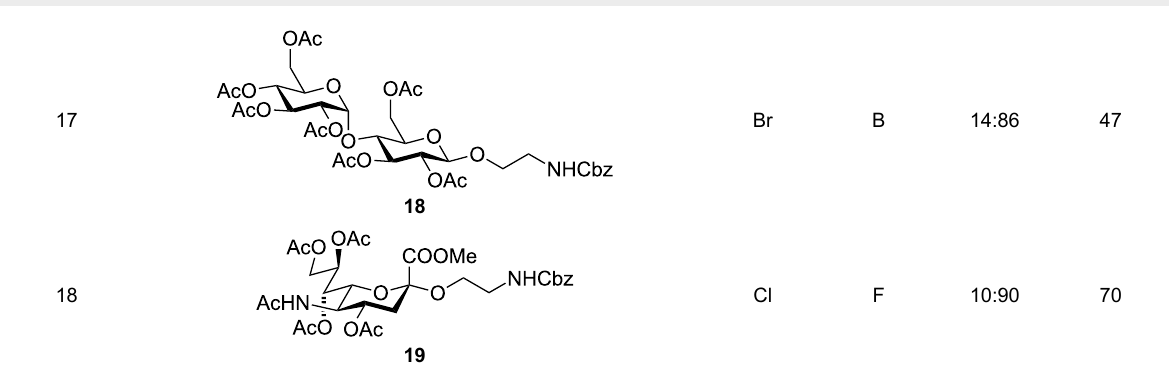
a The reaction was performed overnight at r.t. b The reaction was performed in CH 2 Cl 2 . c determined by 13 C NMR from crude reaction mixture. d Yield of pure major anomer (>95:5) after column chromatography. e Mixture of both anomers. Method A: Hg(CN) 2 , CH 3 CN, 60 °C, 2–4 h. Method B: Hg(CN) 2 , CH 3 CN, 90 °C, microwave, 200 W, 15 min. Method C: BF 3 ·Et 2 O, CH 3 CN, 0 °C, 1 h, r.t., overnight. Method D: SnCl 4 , CH 3 CN, 60 °C, 16 h. Method E: Hg(CN)